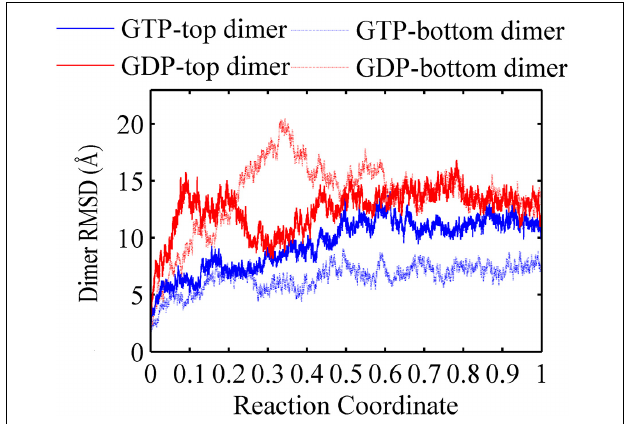
FIGURE 2 | Root mean square deviations of the C α atoms of dimers from the initial conformation as a function of time. Blue solid line: GTP-bound top dimer. Blue dashed line: GTP-bound bottom dimer. Red solid line: GDP-bound top dimer. Red dashed line: GDP-bound bottom dimer. Reaction coordinate: 0 represent 0 ns and 1 represented 150 ns and 450 ns for GTP and GDP state, respectively. The RMSDs are from a starting zero for initial dimer conformation. In all the cases, the RMSDs are calculated by averaging all of the GTP-bound (two runs) or GDP-bound (three runs) trajectories.